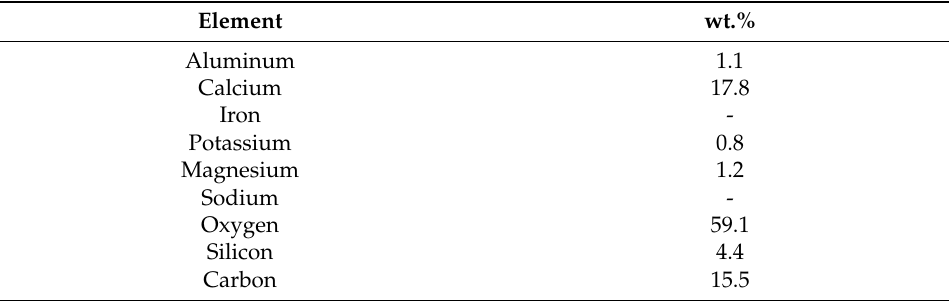
Figure 9. XPS survey spectra of ( a ) cement and ( b ) concrete. Table 5. Surface elemental composition of cement dust from XPS.